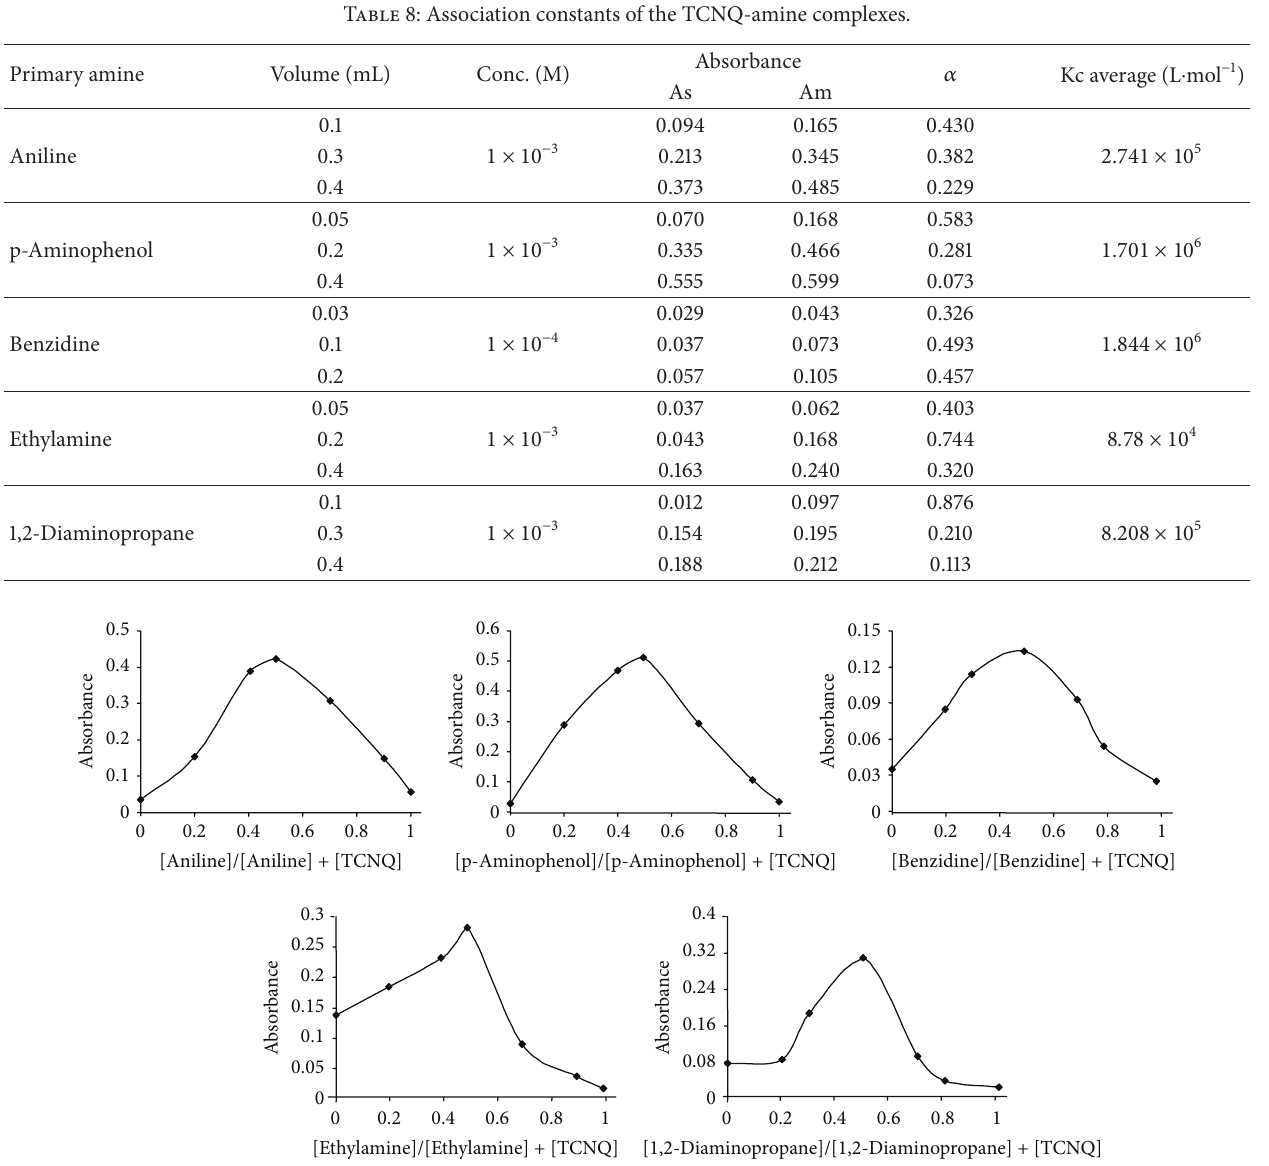
Table 8: Association constants of the TCNQ-amine complexes.